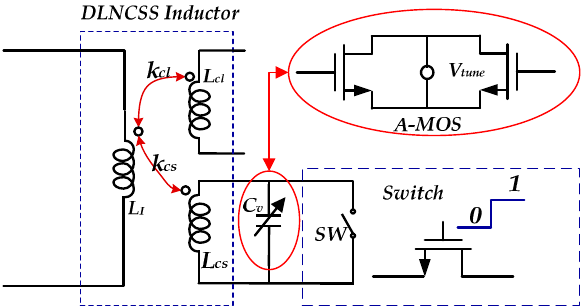
Figure 9. Simple equivalent circuits of the improved transformer-coupled resonant tank.